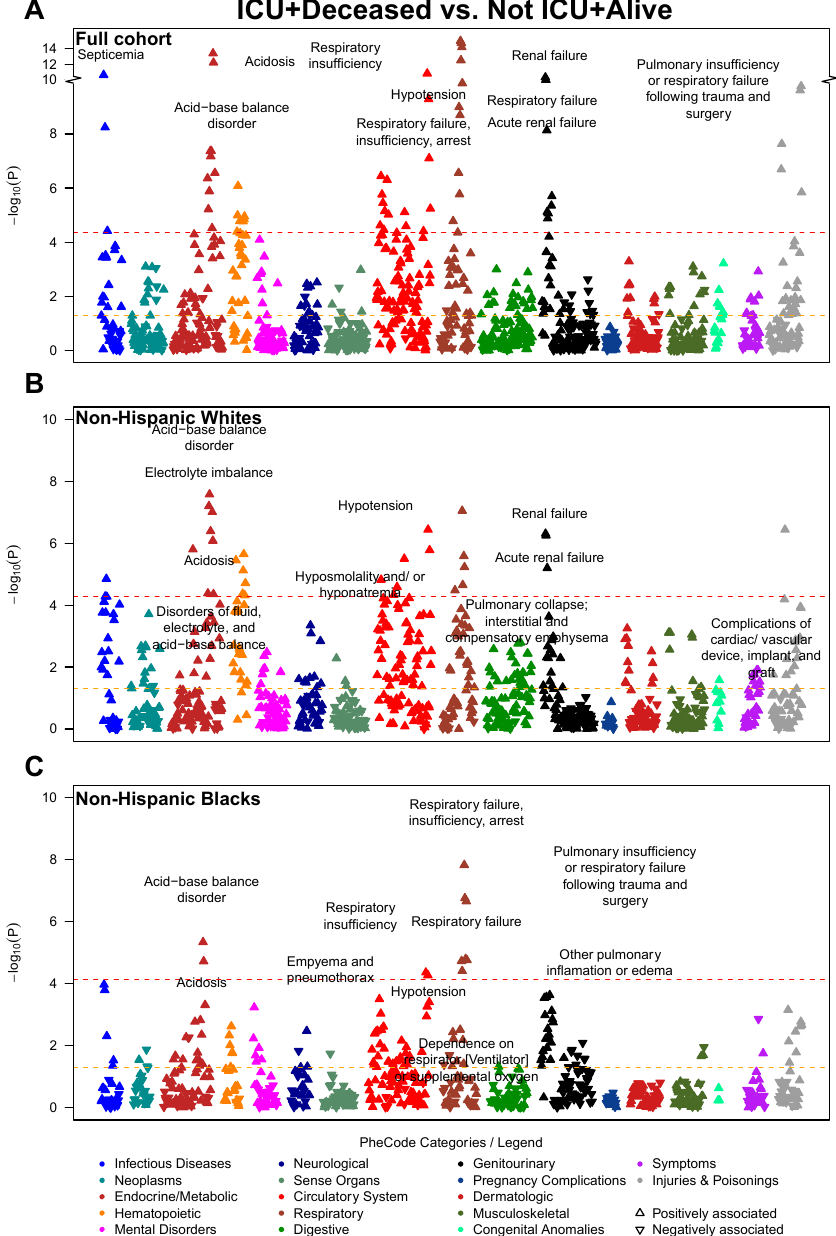
Figure 2. Manhattan plot showing the phenome-wide association between disease conditions and ICU admission for COVID-19. Models are adjusted for age, sex, race (full cohort only), and three census tract-level socioeconomic indicators: proportion with less than high school education, proportion unemployed, and proportion with annual income below the federal poverty level. The x -axis are individual disease codes, color-coded by their corresponding disease category as described in the shared legend. The y -axis represents the − log 10 transformed p -value of the association. The dashed, horizontal lines represent the p = 0.05 (in orange) and the Bonferroni corrected p -value (0.05/number of tests; in red). Each point is represented by either an upward triangle indicating a positive association or a downward triangle indicating a negative association. ( A ): Full cohort, ( B ): Restricted to Whites, ( C ): Restricted to Blacks